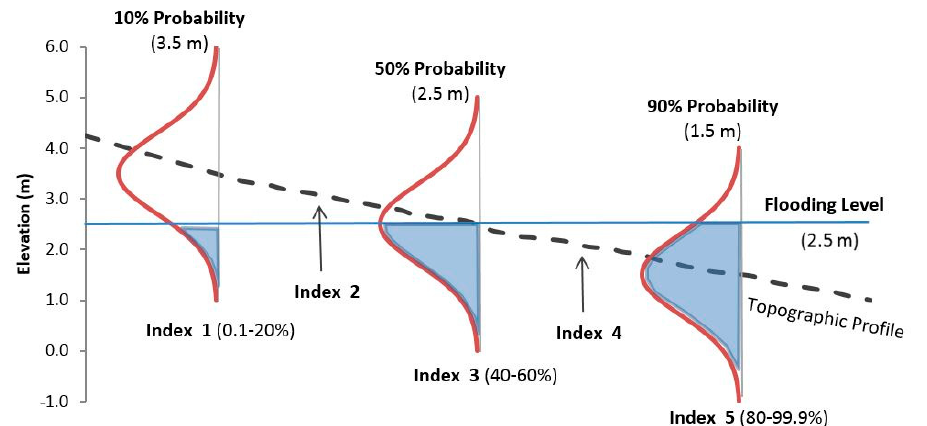
Figure 7. Method for the flooding probability calculation and the EFHI on a generic topographic profile (3.5 m, 2.5 m, and 1.5 m), based on the highest tide level (h = 2.5 m) and its uncertainty (based in Marcy et al. rule for flood confidence area estimation [15]). Intermediate EFHI levels, 2 and 4, are located between index levels 1, 3, and 5, respectively.